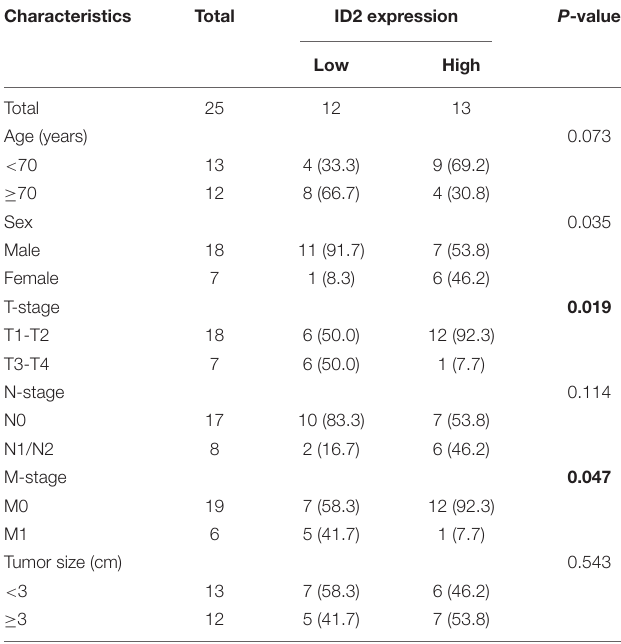
( Figure 1L ) and grade ( Figure 1M ) in TCGA patients. In addition, the chi-squared assay showed that ID2 expression correlated with T-stage, pathological stage and grade ( Table 1